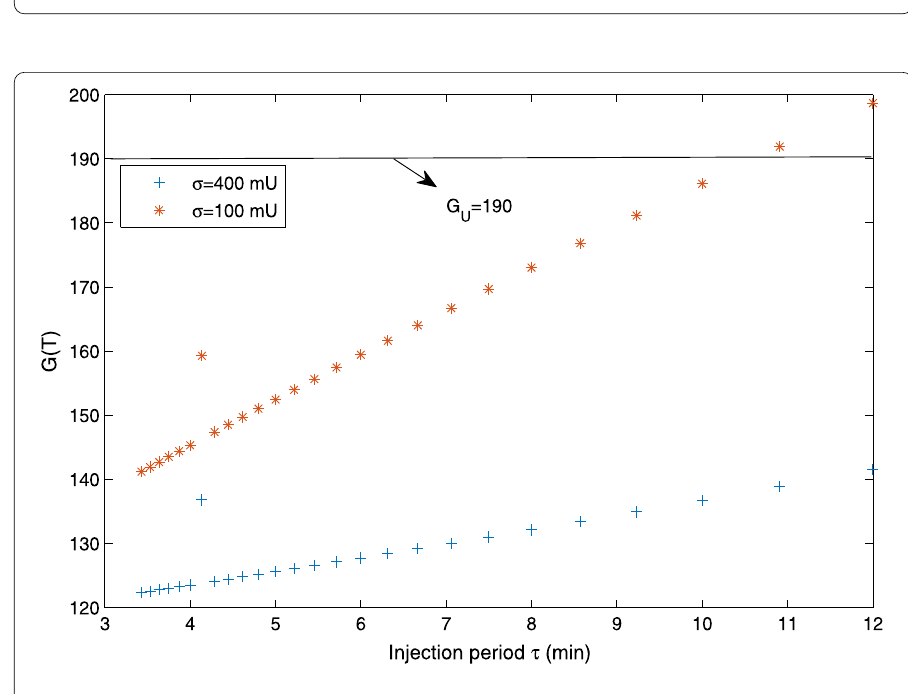
Figure 5 Comparison of the profiles produced by Model (2) with different injection periods with G 0 = 210 mg/dl, σ = 400